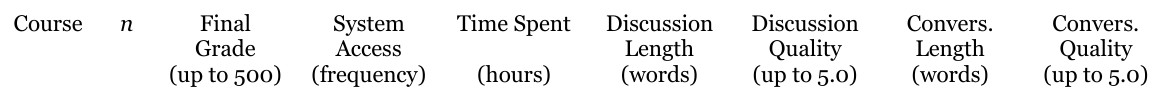
Means and Standard Deviations of Variables (N =